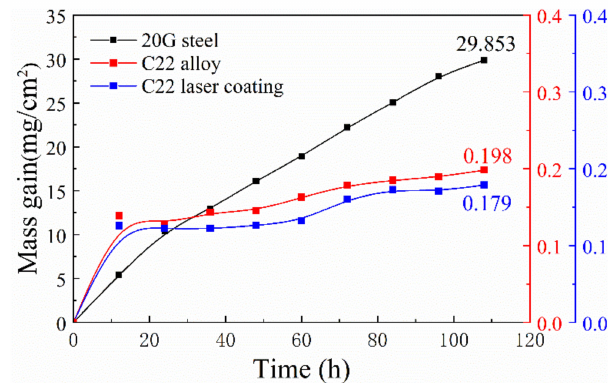
Figure 3. Average mass gain of 20G steel, C22 alloy and C22 laser coating corroded in reducing atmosphere for 108 h at 450 ◦ C.